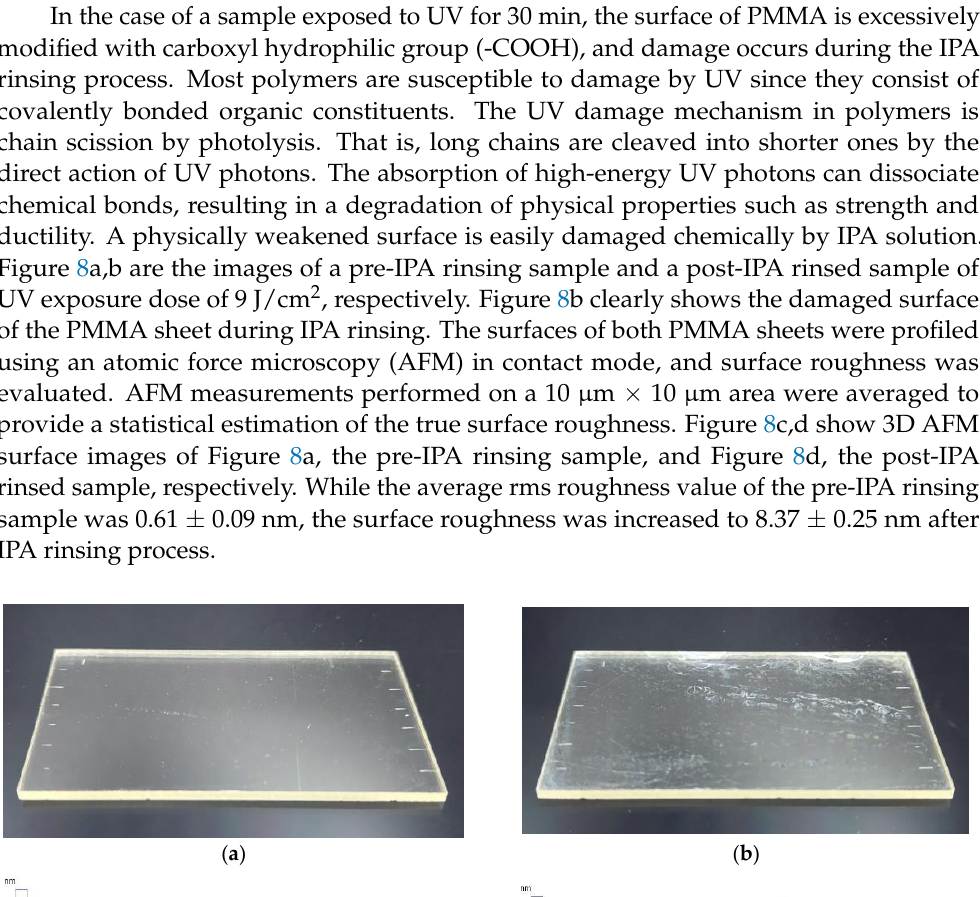
Figure 7. Average change in water contact angles of PMMA surface by storage time after UV-expo- sure for IPA-rinsed PMMA sheets.